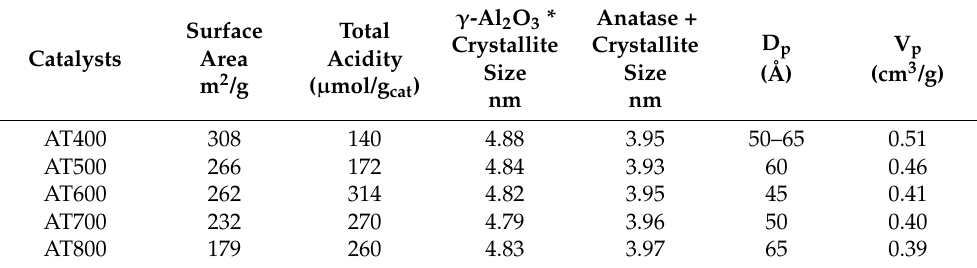
Figure 1. Powder X-ray diffraction data of the γ-Al 2 O 3 -TiO 2 catalyst thermally treated in the 400– 800 °C range. Table 1. Superficial analysis of the